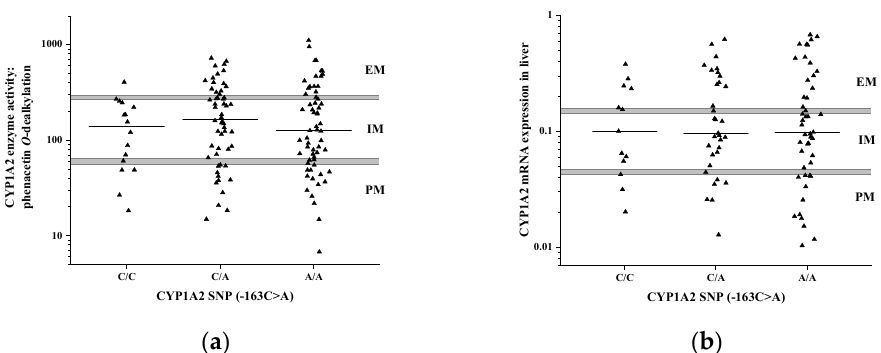
Figure 2. The association between − 163C>A SNP (rs762551) in the regulatory region of CYP1A2 gene and ( a ) hepatic CYP1A2 activity or ( b ) mRNA expression. The horizontal lines display the median values. Abbreviations: PM, poor metabolizer; IM, intermediate metabolizer; EM, normal metabo- lizer.